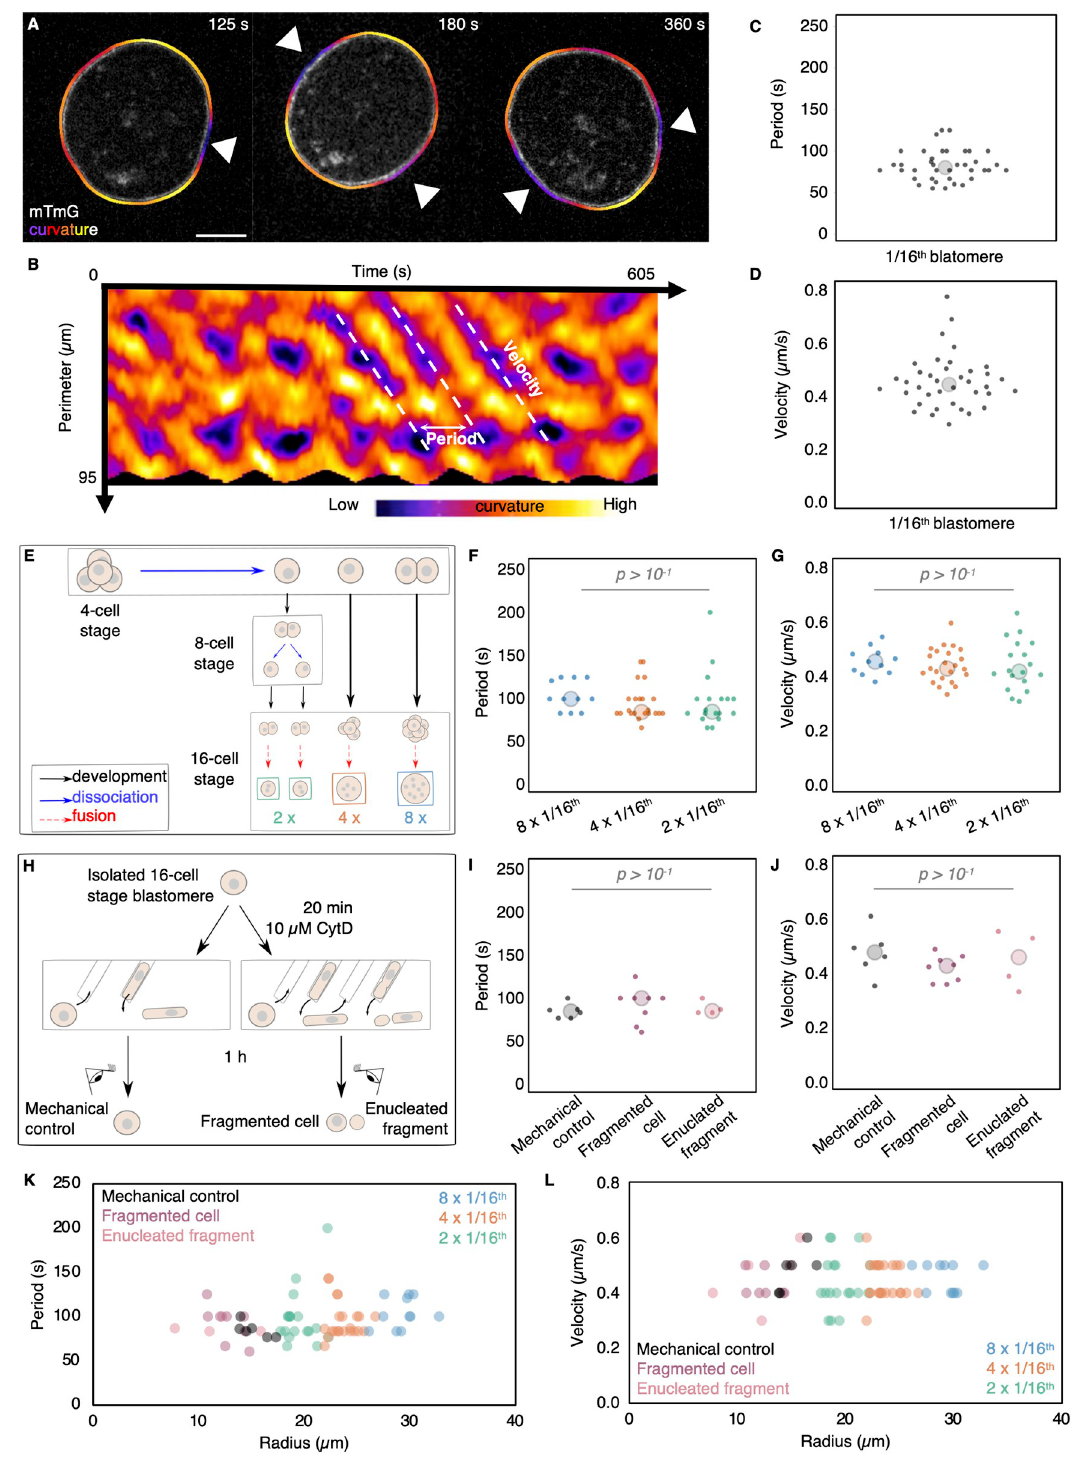
Fig 3. Period and velocity of PeCoWaCo are stable across a broad range of cell sizes. (A, B) Surface deformation tracking for period detection and velocity measurements. Isolated 16-cell stage blastomere originating from mTmG embryos with the local curvature fitted around it (A). Arrowheads indicate the PeCoWaCo. White scale bar, 10 μ m. (B) Kymograph of curvature changes observed in the cell shown in (A). The period between consecutive waves and their velocity are indicated. Colored scale bar indicates curvature. (C, D) Period (C) and velocity (D) of PeCoWaCo in 38 isolated 16-cell stage blastomeres. Large circles show median.